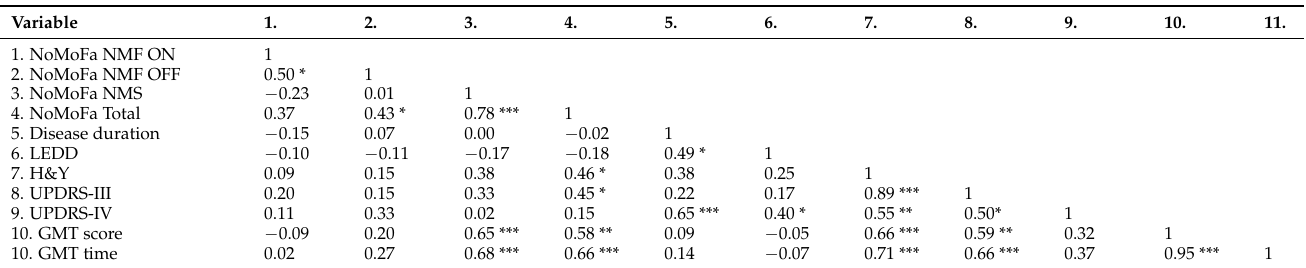
Table 3. Spearman’s correlation coefficients between NoMoFa subscores and total score, clinical data, and GMT